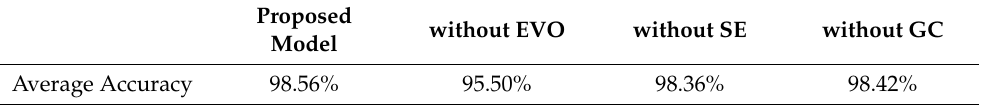
Table 4. Performance comparison on PhysioNet MIT-BIH with three components.